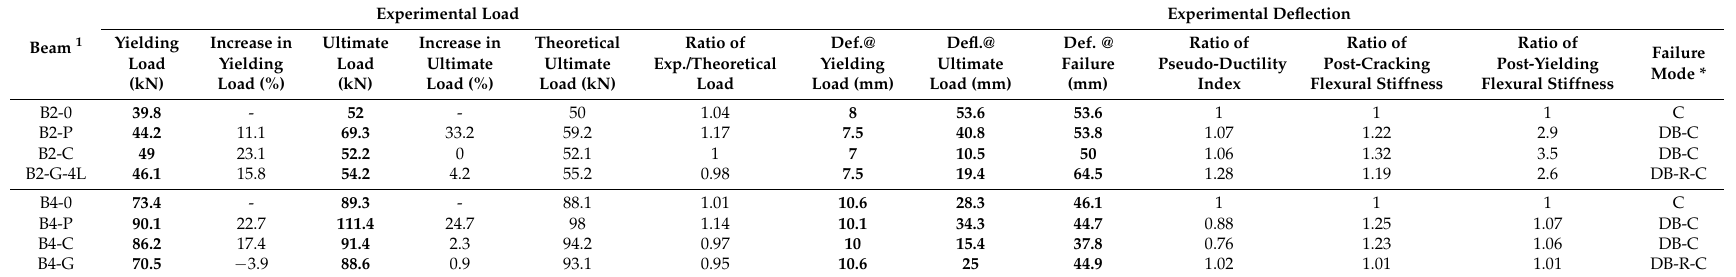
Table 4. Summary of the test